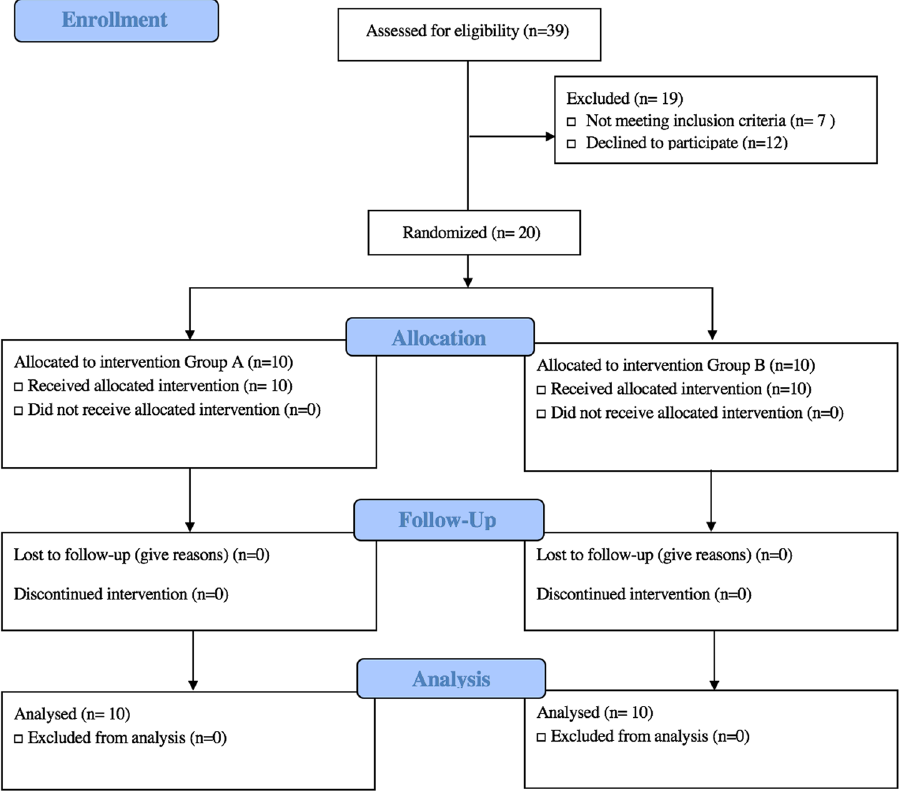
Figure 2. Consort Study Flow Diagram.